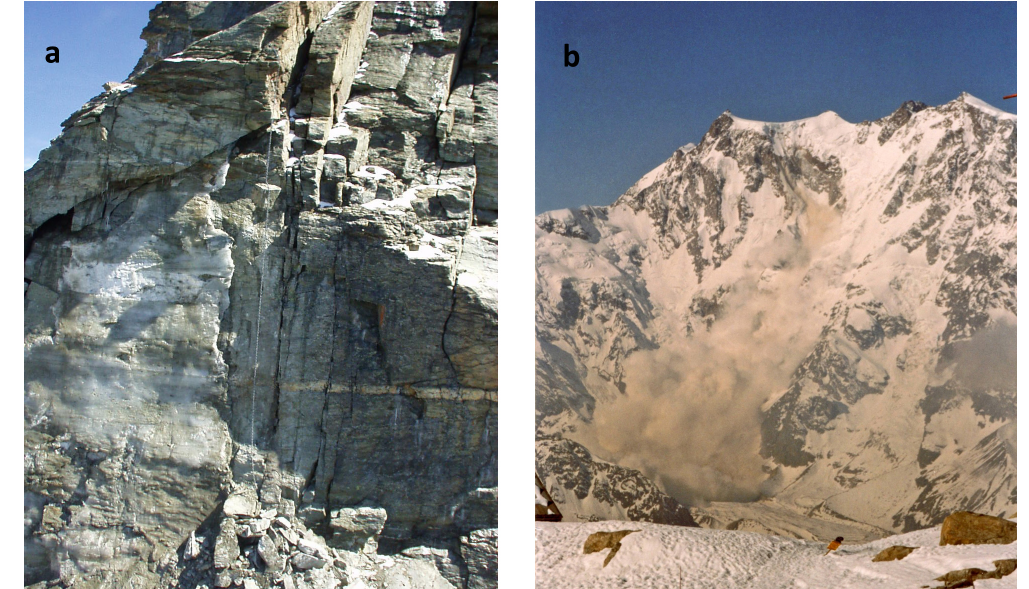
Figure 2. Selected examples of rockfall events. (a) Detachment area of the Matterhorn II rockfall (18 August 2003), with the ice lens (on the left) exposed by the collapse of the rock mass; photo source: L. Trucco. (b) Belvedere rock avalanche (21 April 2007); photo source: F.